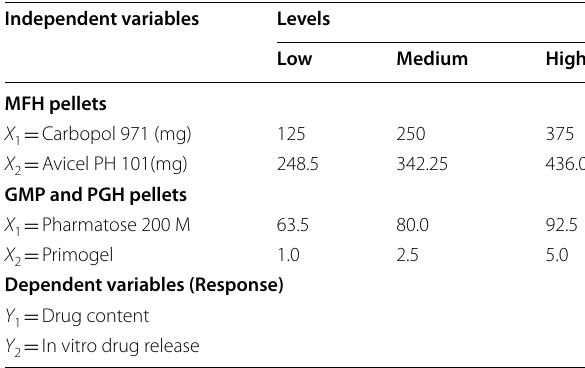
Table 5 Variables in 3 2 optimal response surface designs for pellets Independent